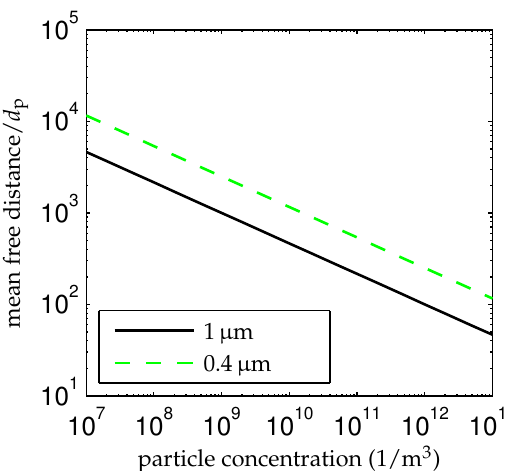
Figure 7. Mean free distance of the seeding particles divided by the particle diameter d p over the seeding particle concentration for two different particle diameters.